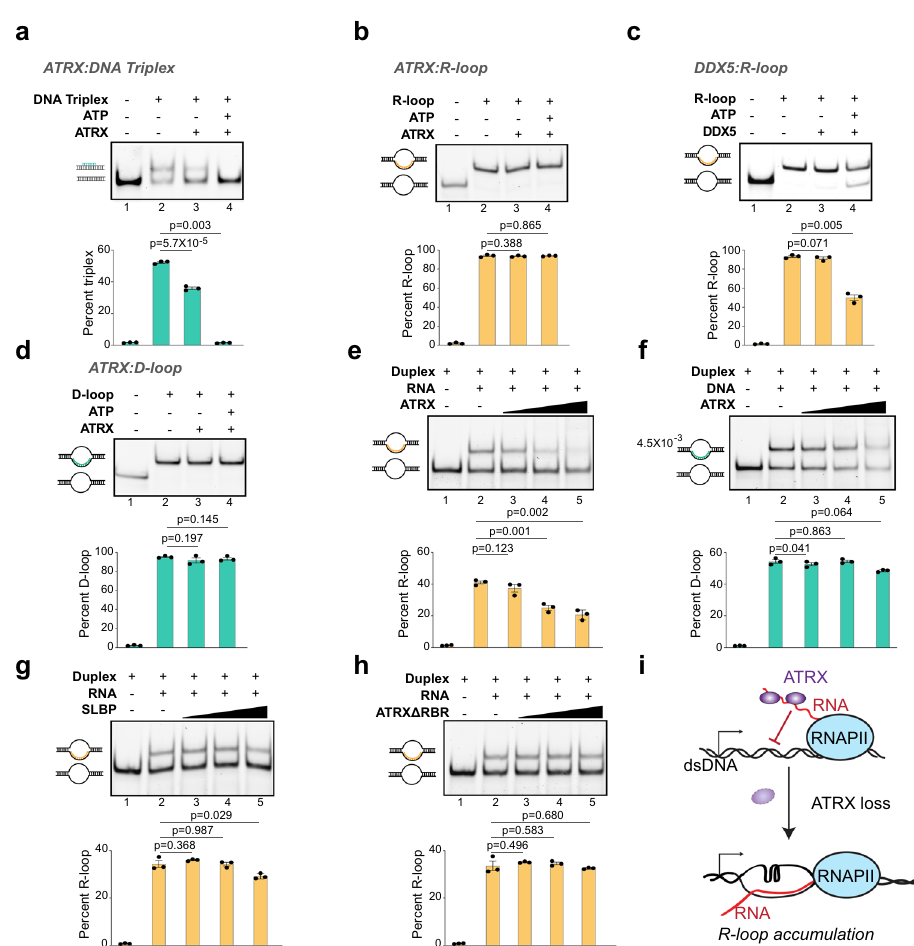
Fig. 2 ATRX RNA binding activity inhibits R-loop formation. a DNA strand displacement assay with full-length ATRX (25 nM) and 1 nM DNA triplex substrates with or without ATP as indicated. Positions of duplex and DNA triplex are shown. For all subsequent panels in this fi gure, quanti fi cation of 3 independent experiments is shown as mean values ± SEM. p, two-sided Student ’ s t-test. b R-loop resolution assay with full-length ATRX (25 nM) and 1 nM R-loop substrates with or without ATP as indicated. Positions of duplex and R-loops are shown. c R-loop resolution assay with 25 nM DDX5 and 1 nM R-loop substrates without or with ATP as indicated. d D-loop resolution assay with full-length ATRX (25 nM) and 1 nM D-loop substrates with or without ATP as indicated. Positions of duplex and D-loops are shown. e R-loop formation assay with 1.25 nM DNA duplex, 3.75 nM RNA and increasing concentrations of full-length ATRX (5, 25, 125 nM). f D-loop formation assay 1.25 nM DNA duplex, 3.75 nM ssDNA and increasing concentrations of full- length ATRX (5, 25, 125 nM). g R-loop formation assay with 1.25 nM DNA duplex, 3.75 nM RNA, and increasing concentrations of full-length SLBP (5, 25, 125 nM). h R-loop formation assay with 1.25 nM DNA duplex, 3.75 nM RNA, and increasing concentrations of ATRX Δ RBR (5, 25, 125 nM). i Model: ATRX interacts with repeat containing RNAs through its RNA binding region and prevents their incorporation into R-loops. ATRX deletion allows RNAs to hybridize to their complementary DNA, resulting in R-loop stabilization and accumulation. Source data underlying ( a – h ) are provided as a Source data fi RH Δ -TurboID did not show an enrichment for ribosomal pro- teins (4 out of 441, Supplementary Fig. 3b, c) and was more sensitive in detecting lowly expressed proteins as demonstrated by the large proportion of transcriptional regulators (Fig. 3b). We performed a domain enrichment analysis 44,45 to identify speci fi c protein domains that were enriched in RH Δ -TurboID and S9.6 IP (Fig. 3c, Supplementary Data 1). Our results showed that both RH Δ -TurboID and S9.6 IP contained proteins with helicase- related domains (Helicase C, SNF2_N, DEAD/DEAH) that are